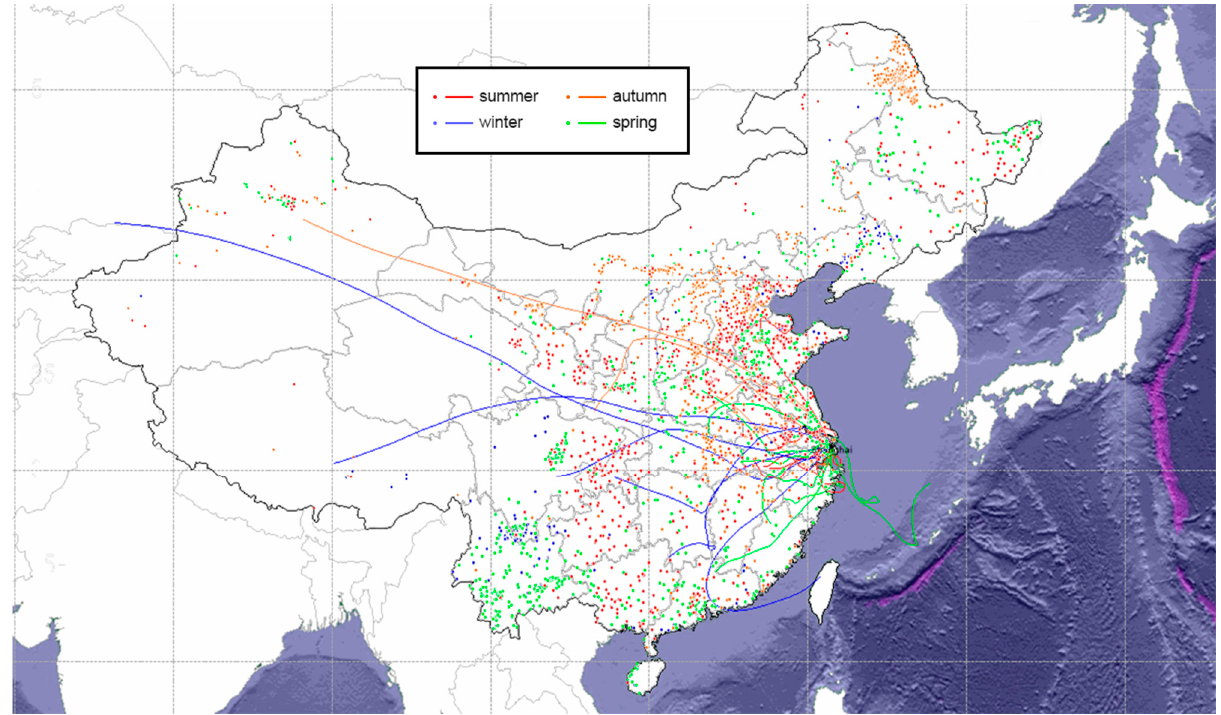
Figure 8. The 72-h air mass backward trajectories (AMBTs) at an arrival height of 1500 m of the sampling site and simultaneous fire count maps. The air mass trajectory was traced backward for three days starting at 12 a.m. each day on the sampling date.